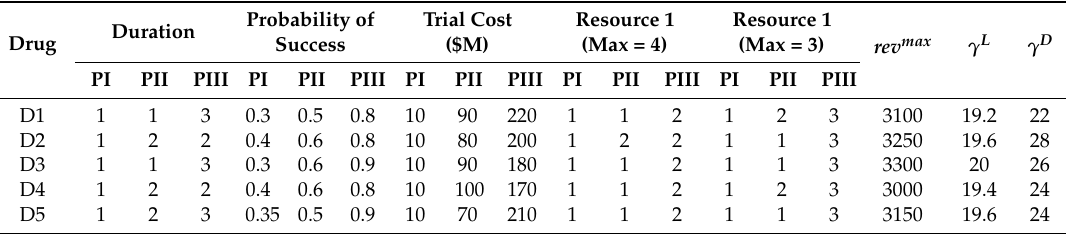
Table A4. Parameters of the five-drug case